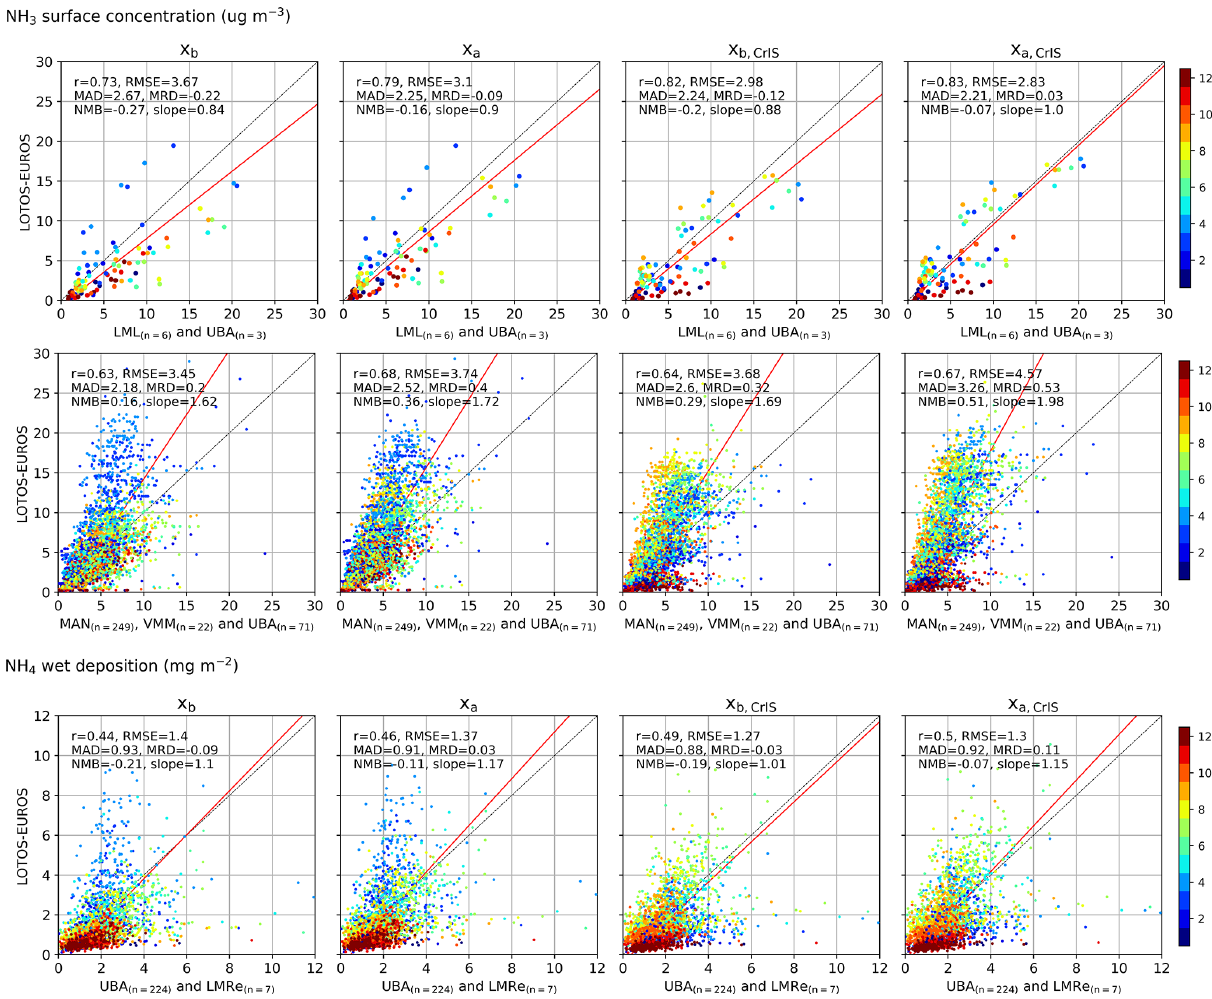
+ wet deposition fields to in situ observations. 4